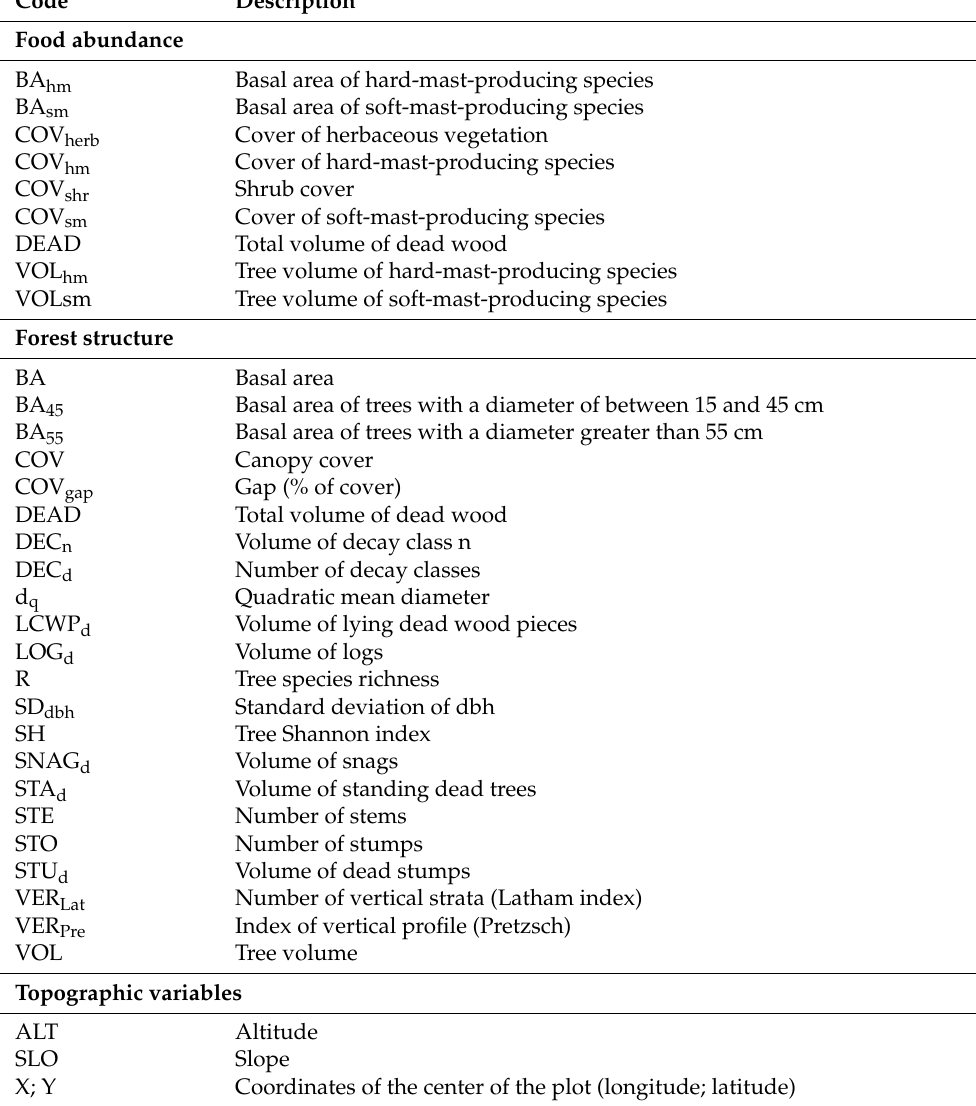
Table 2. List of continuous variables used to predict proxies of key foods for Apennine brown bears. Code